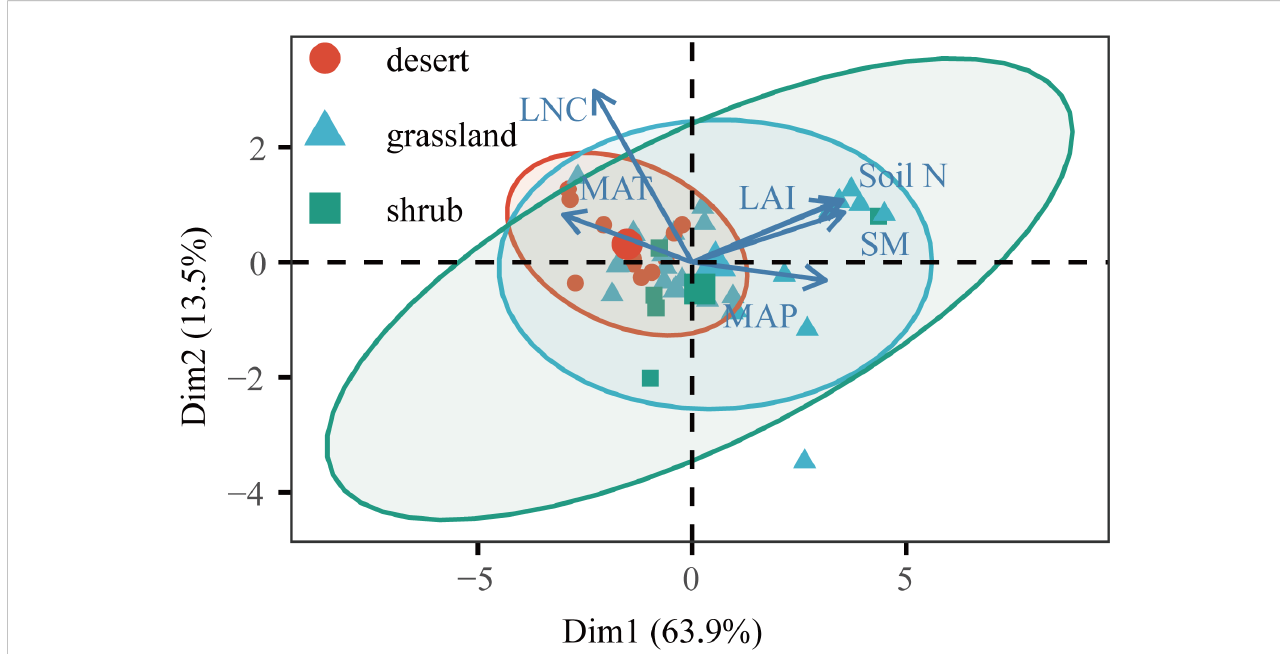
FIGURE 7 Environmental dimensions from principal component analysis (PCA) for Chinese drylands. Variables used for the PCA are displayed with their vector. The environmental factors were normalized and standardized by transforming the observations into z-scores. MAT, mean annual temperature; MAP, mean annual precipitation; LAI, leaf area index; Soil N, soil total nitrogen content; LNC, leaf nitrogen content; SM, soil moisture.